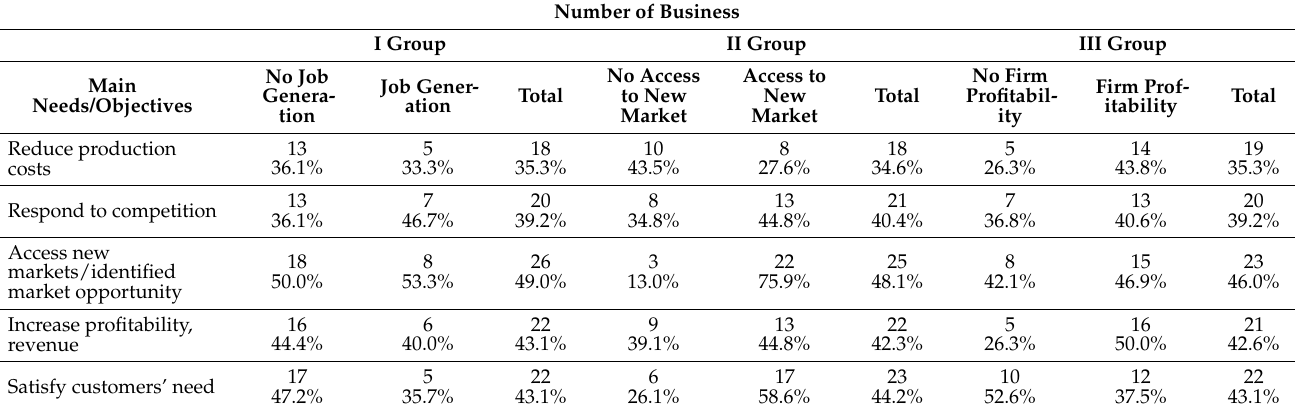
Table 2. The main needs/objectives for rural SMEs to adopt the new